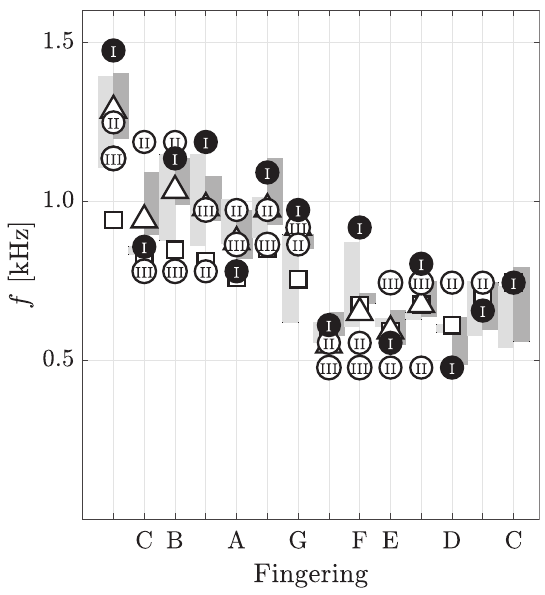
Figure 7. Estimation of the cutoff frequency for each fi ngering down to the low C (written, 156 Hz) of an alto saxophone. Data markers correspond to: the fi rst three f P c